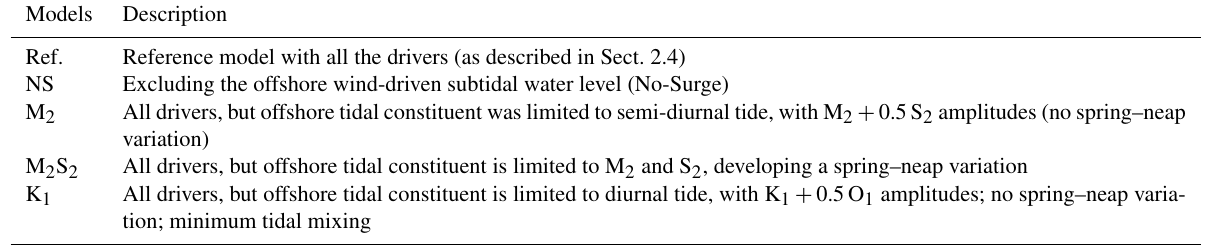
Table 2. List of simulations run in this study with a brief description.